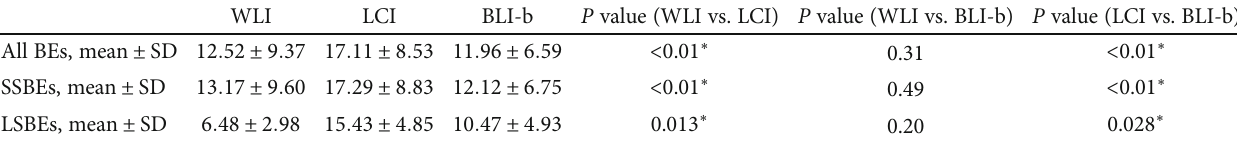
Table 3: The color di ff erences ( Δ E ∗ ) of BE from the adjacent gastric mucosa in WLI, LCI, and BLI-b modes. WLI LCI BLI-b